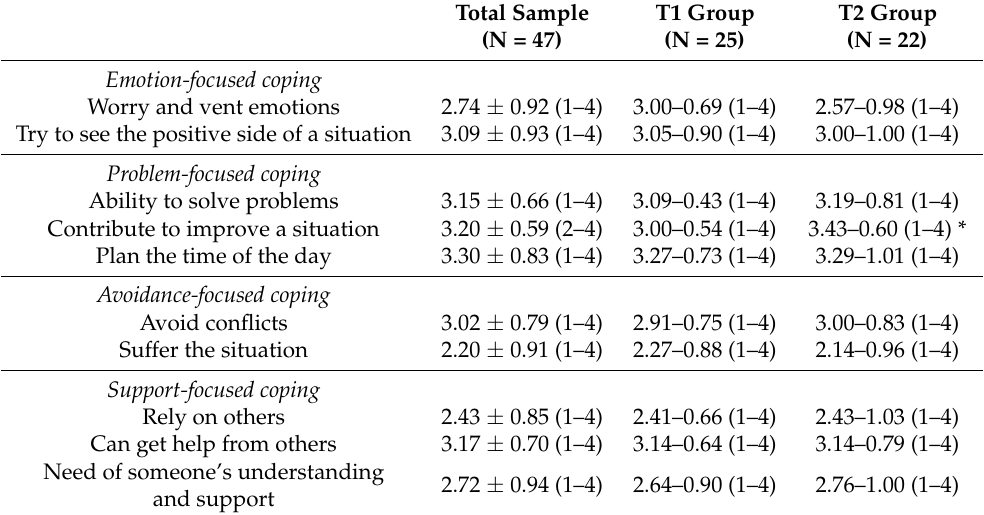
Table 4. Ways of coping.